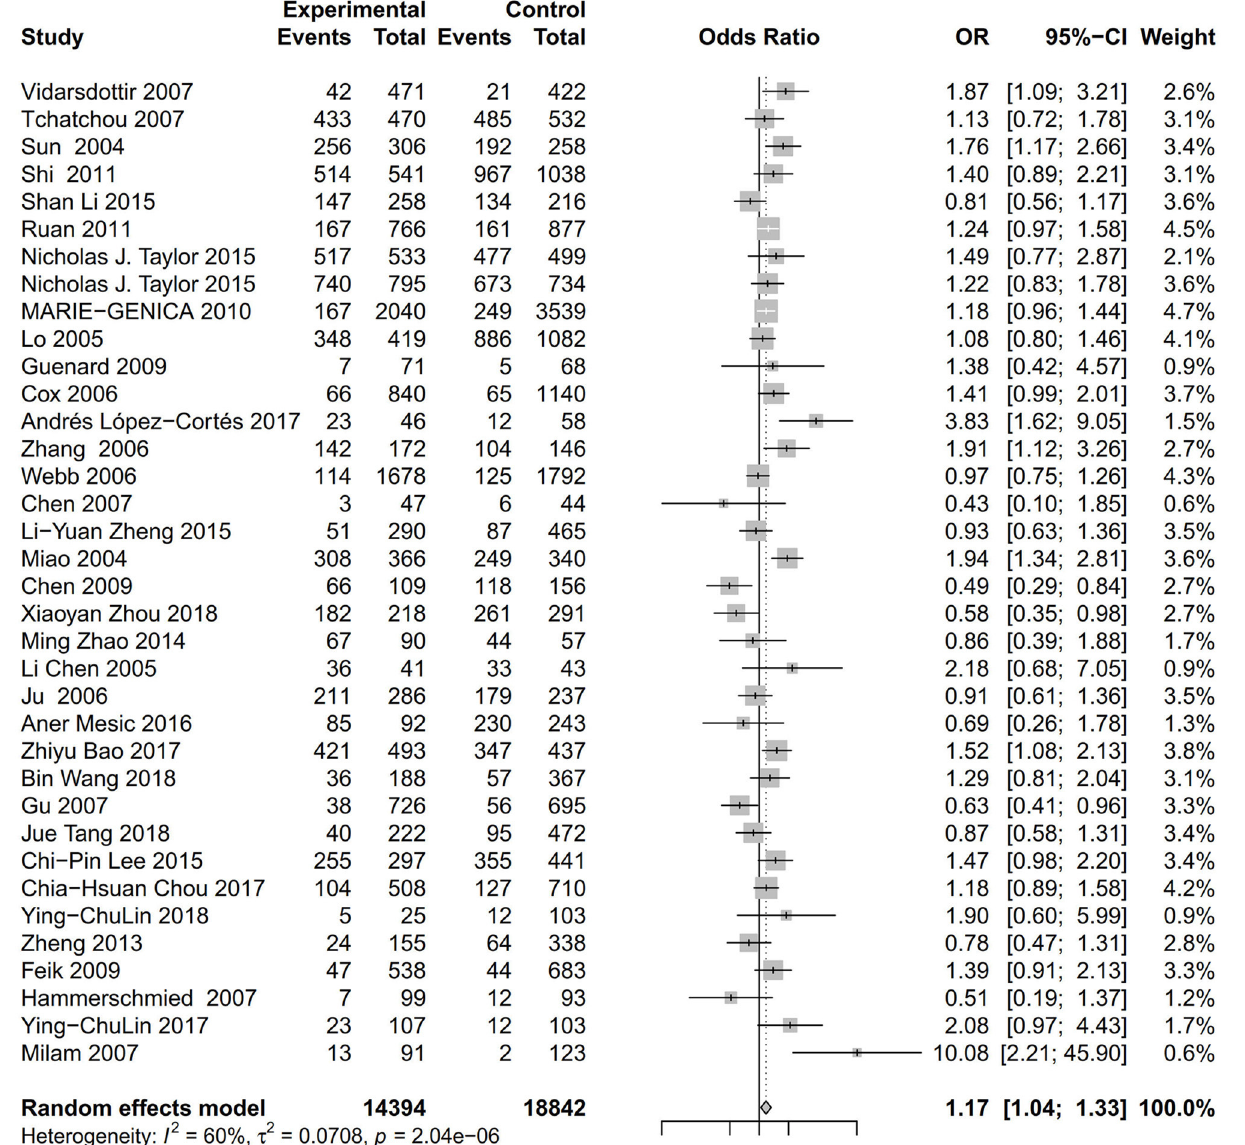
(Phe) > isoleucine (Ile)) is related to cellular transformation and distinctly enhances chromosomal instability (75). This polymorphism can also cause an obstruction in p53 binding and decreased degradation of AURKA by changing the activity of the AURKA box 1 (16). Research has shown that the stabilized over-expression of AURKA results in centrosomal amplification, abnormal cytokinesis, chromosomal instability, and the promotion of tumorigenesis. Numerous studies have been performed to explore the association between the rs2273535 polymorphism and the risk of various types of